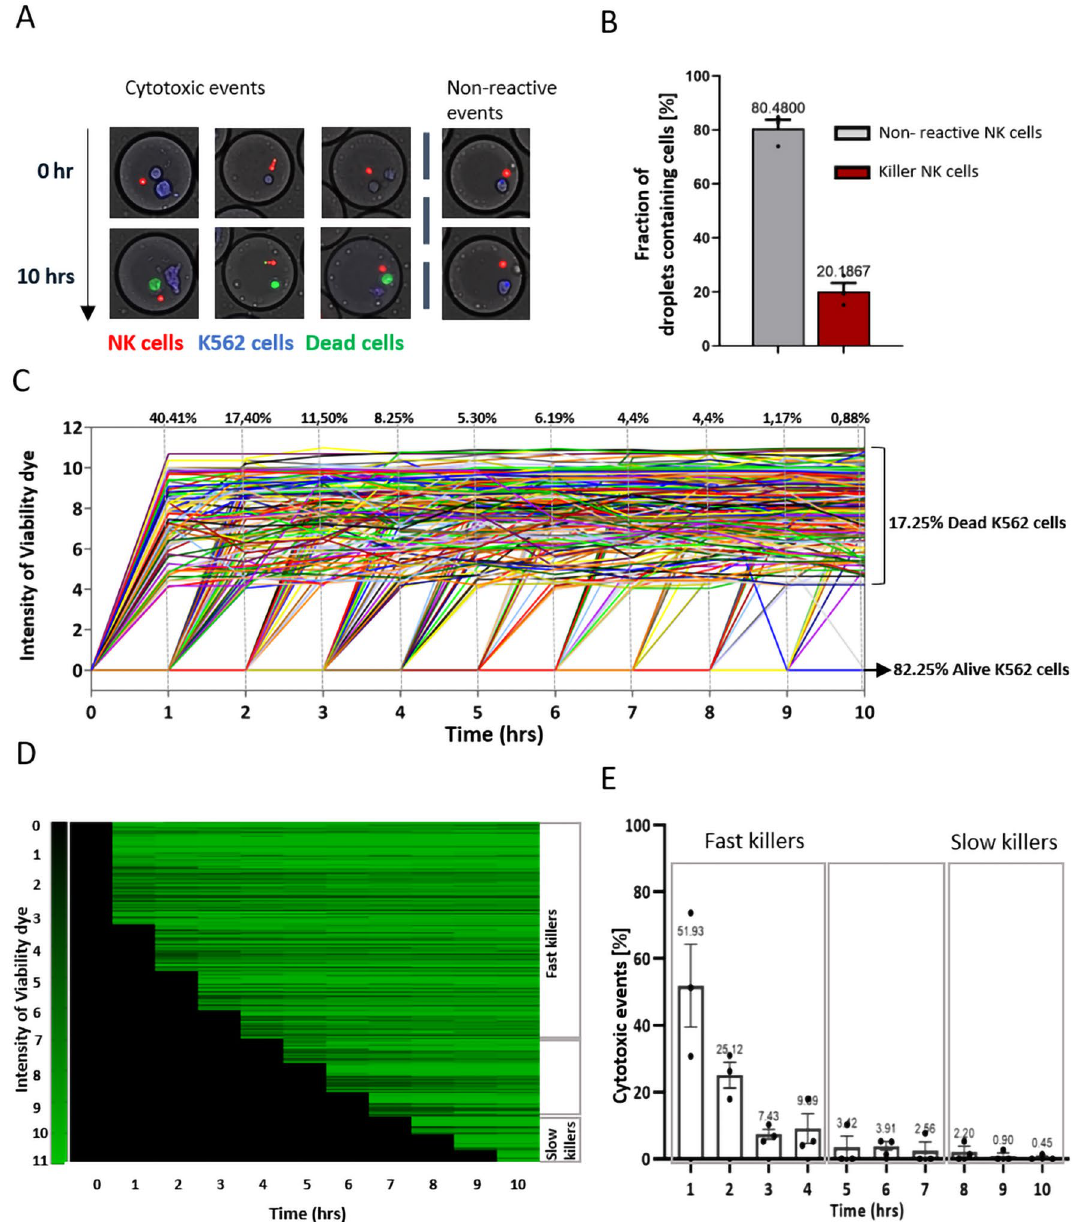
Figure 5. NK cytotoxicity in real-time. ( A ) Microscopic overview of NK cell-mediated cytotoxicity in droplets. NK cells were labelled with Calcein Red AM dye (red cells) and K562 cells with Cell Tracker Blue (blue cells) and paired together in 70 pL droplets in presence of viability dye (Sytox green and Cell event Caspase 3/7). They were then incubated at 37 °C and 5% CO 2 for 10 h. Image acquisition was done at an hour interval. Over the interval of 10 h, NK cells are interacting with target cells, either, with (left) or without inducing cytotoxicity (right). The cells that die are stained with the viability dye and thus turn green. The live cell retains the original color. ( B ) Bar diagram representing killer fraction of NK cells in droplets; data analysis performed on E:T 1:1; n = 3 independent experiments; error bar represents standard error of mean. ( C ) A representative experiment showing intensity of the viability for K526 cells upon interaction with NK cells plotted over time. Each line represents individual cells; n = 66,600 total droplets with 20,860 droplets containing cells. The graph does not include the droplets with 0, or 1 cell and droplets with dead cells at t = 0 h. An alive cell gives the intensity of viability dye as “0”, cells with values above zero are considered as dead. ( D ) Heat Map showing the dynamics of cytotoxicity within an experiment. Each line represents individual cells. The viability was assessed over the period of 10 h. ( E ) Graph representing the dynamics of cytotoxic events in droplets for different donors. The dynamics were determined for the killer fraction of NK cells, thus showing the percentage of the fast and slow killer population in NK cells; data analysis performed on E:T 1:1; n = 3 independent experiments; error bar represents standard error of